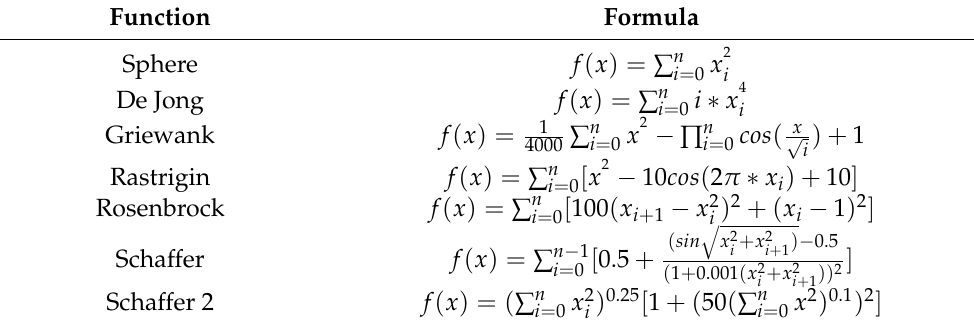
Table 1. Description of the employed functions for testing PSO.